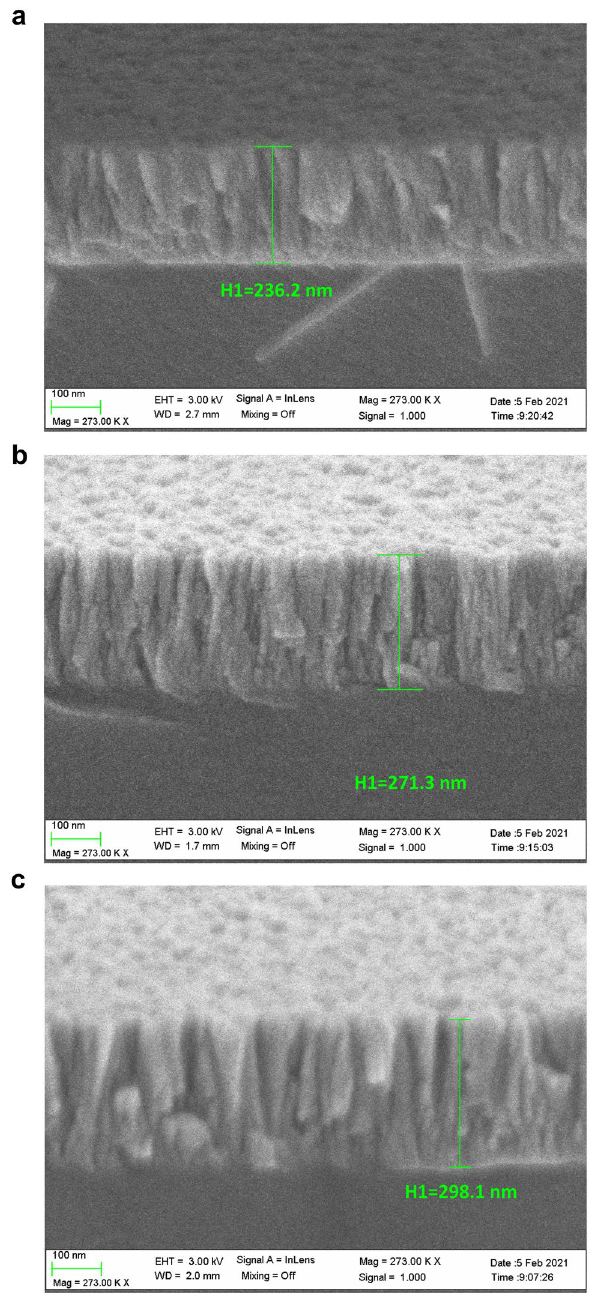
Figure 5. Scanning electron microscope (SEM) images for the sample deposited using a mask during the deposition process and a platform of angle 30º: (a) first electrode corresponding to the thinner region; (b) intermediate thickness; and (c) thicker